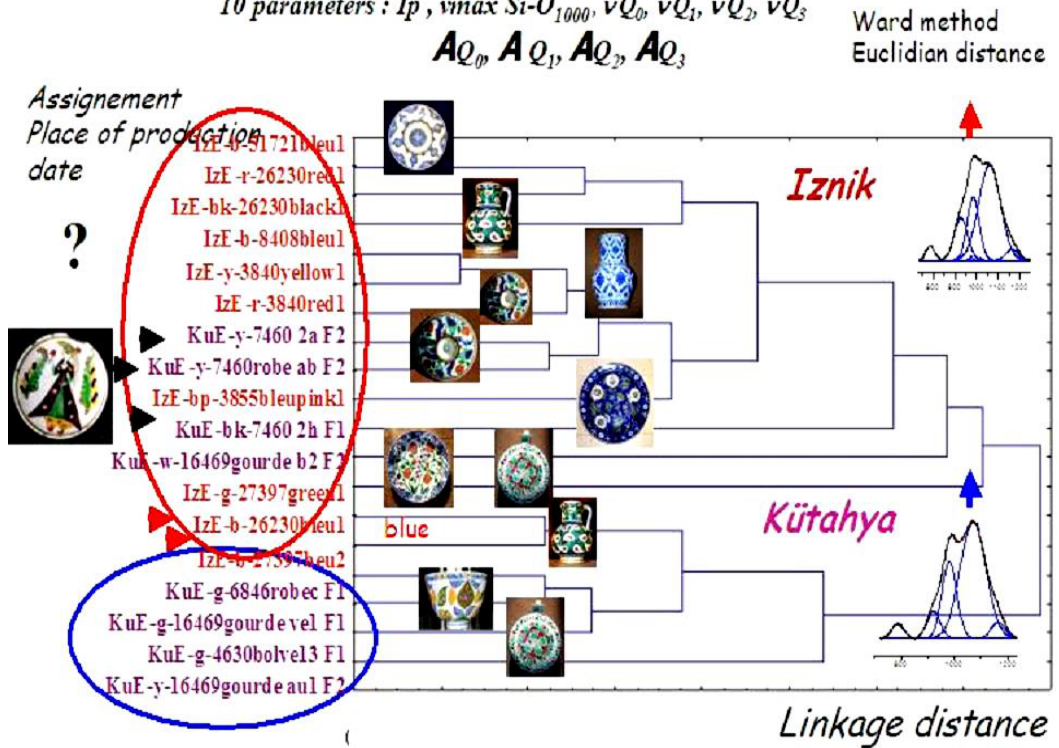
Figure 4. Parameters extracted by modeling the Raman signatures of the glazes of various artifacts assigned to Iznik and Kütahya Ottoman production were classified using the cluster classification technique to establish a procedure of indentification